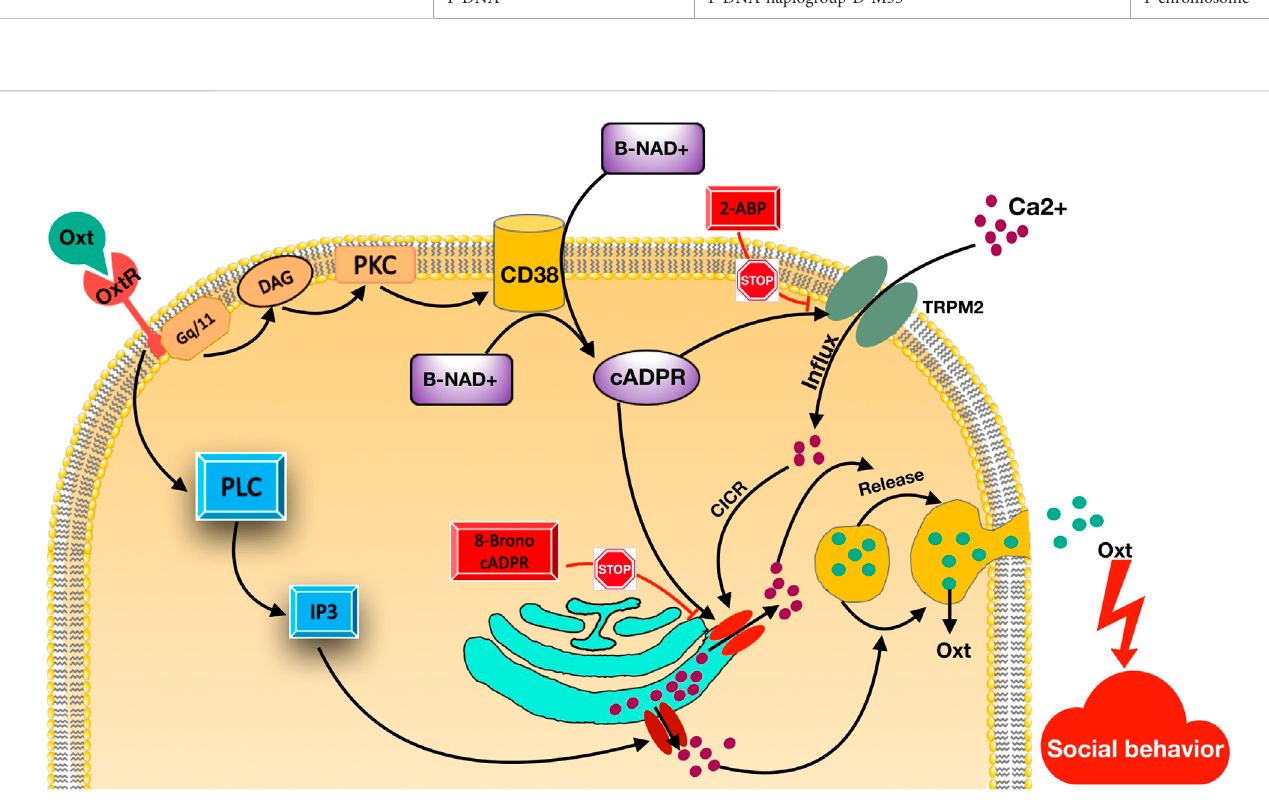
FIGURE 2 Oxytocin-relatedsignalingpathway.Oxytocinreceptors(OTR)stimulatedbyOxytocin(OT;greencircles).Then,theG q/11 typeGTP-bindingproteinand phospholipase C (PLC) are activated, leading to creation of inositol-1,4,5-trisphosphate (IP3) and diacylglycerol (DAG). This results in Ca 2+ mobilization activation from IP 3 -sensitive Ca 2+ pools. CD38 activated by stimulated protein kinase C (PKC) and increases cADPR creation from β -NAD + inside or outside cells. cADPR using a mechanism mentioned as Ca 2+ -induced Ca 2+ release, mobilizes Ca 2+ via cADPR-sensitive Ca 2+ pools. cADPR triggers Ca 2+ in fl ux TRPM2 cation channels. TRPM2 channels can inhibit by 2-Aminoethoxydiphenyl borate (2-APB). TRPM2 facilitates Ca 2+ in fl ux, which also trigger Ca